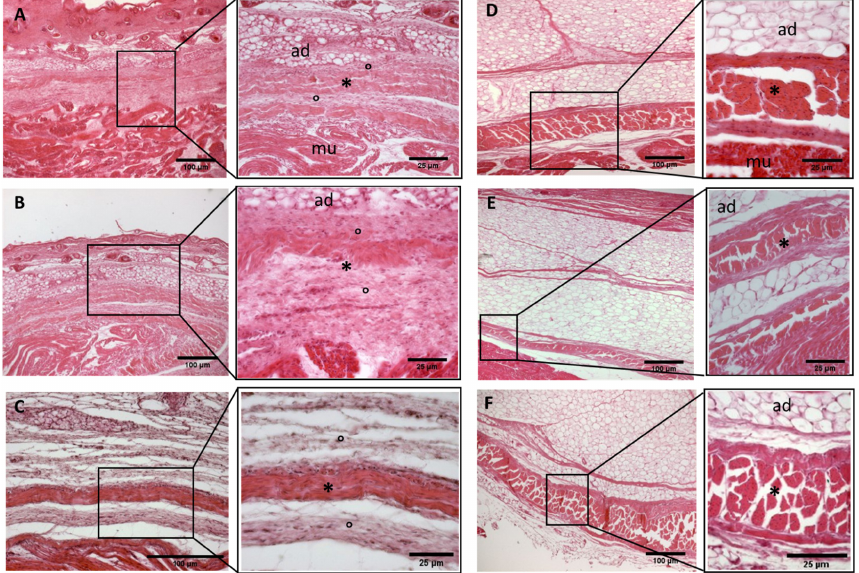
Figure 3. Histological images (hematoxilyn-eosin) of lower limb, thigh: lateral fascia (iliotibial tract) development. ( A ): 24 weeks; ( B ): 27 weeks; ( C ): 29 weeks; ( D ): 36 weeks; ( E ): 38 weeks; ( F ): 40 weeks. (*): deep fascia; (°): mesenchymal cells; (mu): muscle; (ad): adipose tissue. The first part of gestation is distinguished ( A – C ) by an irregular connective tissue with a huge cellularity without clear organization in layers, whilst the second part of the gestation ( D – F ) showed up with a denser connective tissue, which was better organized in the fascial layers. The middle layer was the most prominent and consisted of compact bundles of collagen fibers, while the outermost layers show a woven-like and thin pattern ( F ).